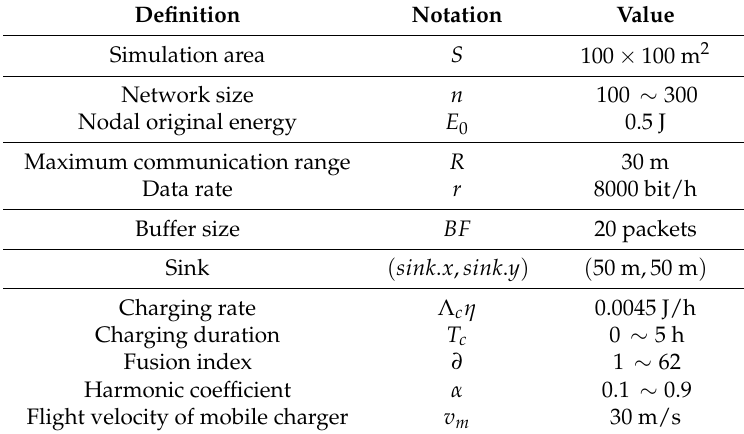
Table 1. Simulation